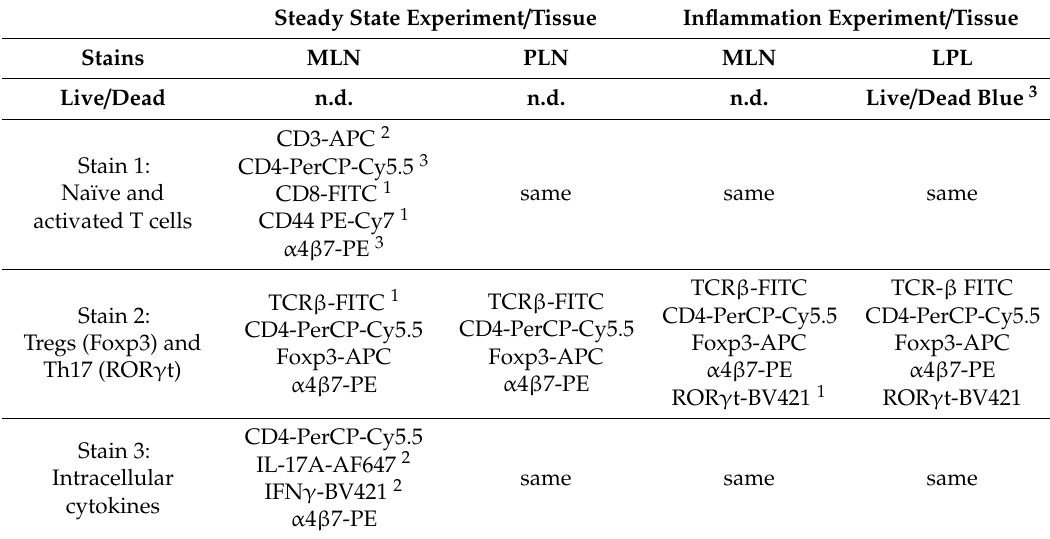
Table 1. Antibody-fluorophore combinations used in two